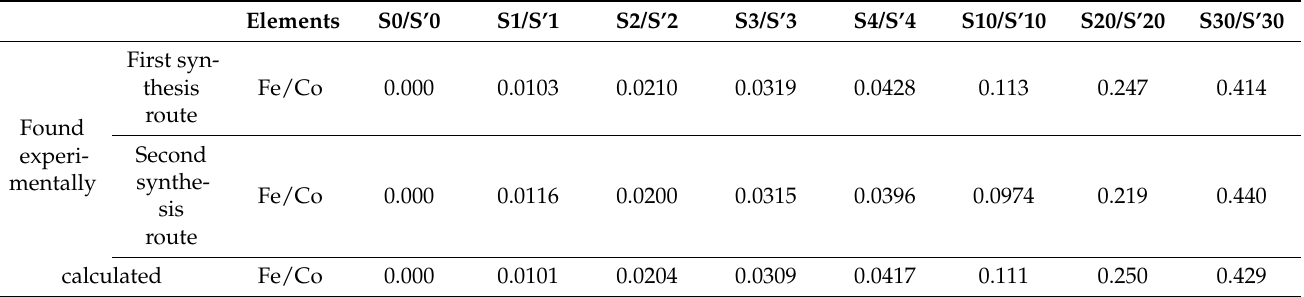
Table 2. Comparison between expected and obtained mole ratio of metal in the